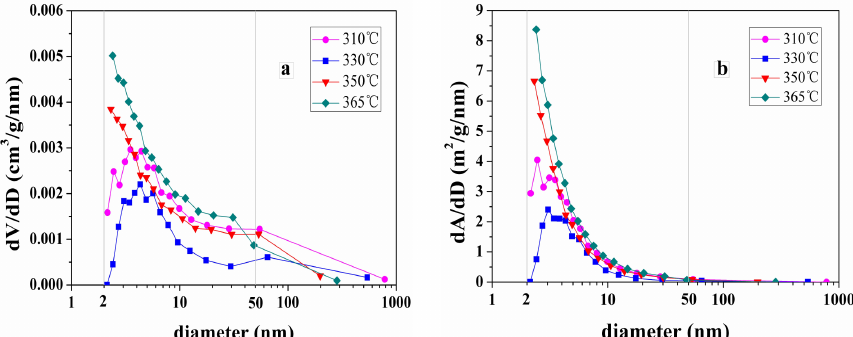
Figure 9. ( a ) Pore size distribution and ( b ) specific surface area of spent samples extracted by sub-critical water for 150 h at different